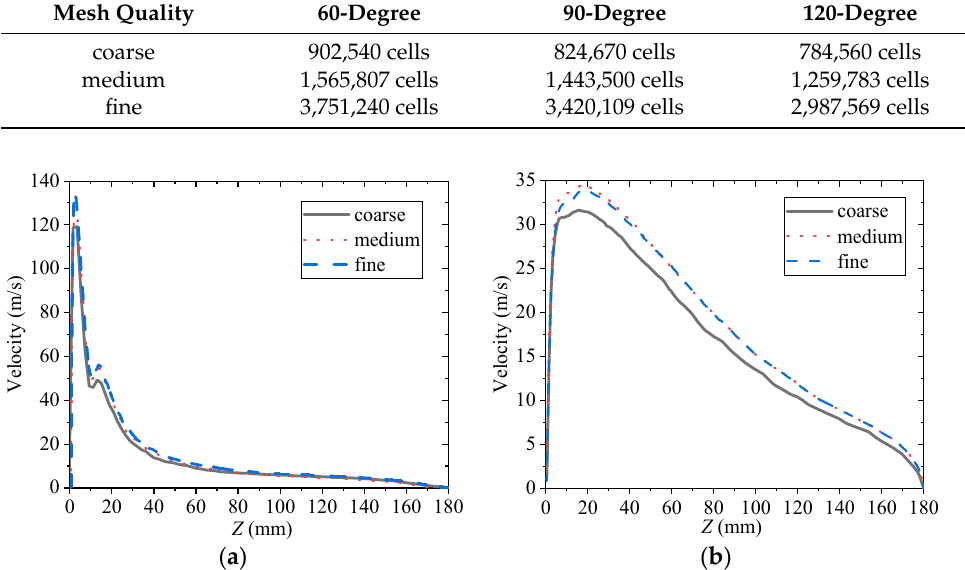
Figure 5. Gas ( a ) and liquid ( b ) velocities along the Z ‐ axis for the simulation of the 90 ‐ degree arc connecting surface with different sets of meshes.